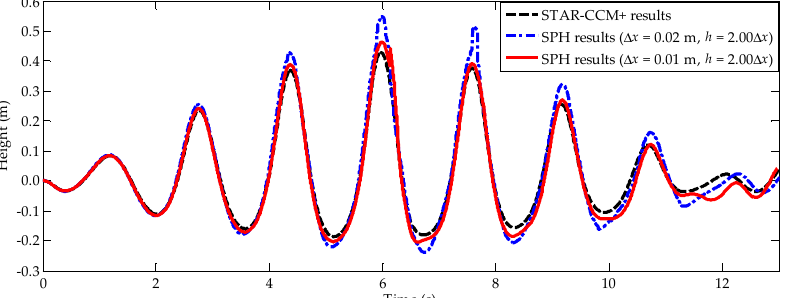
= Δ = Δ for the wave elevation at the for the wave elevation at the